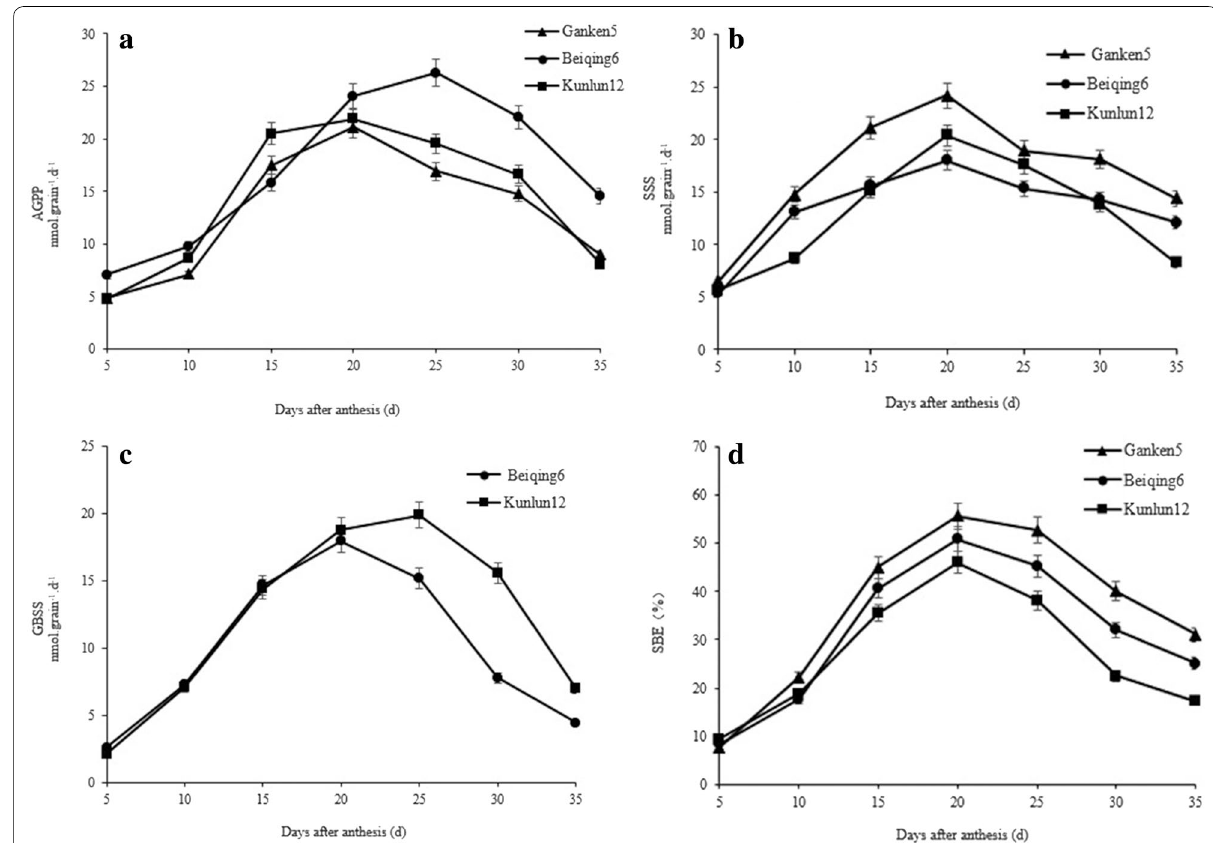
Fig. 4 Activity of AGPP, SSS, GBSS and SBE in three hulless barley cultivars during grain filling. a AGPP enzyme; b SSS enzyme; c GBSS enzyme; d SBE enzyme. Error bars indicate standard